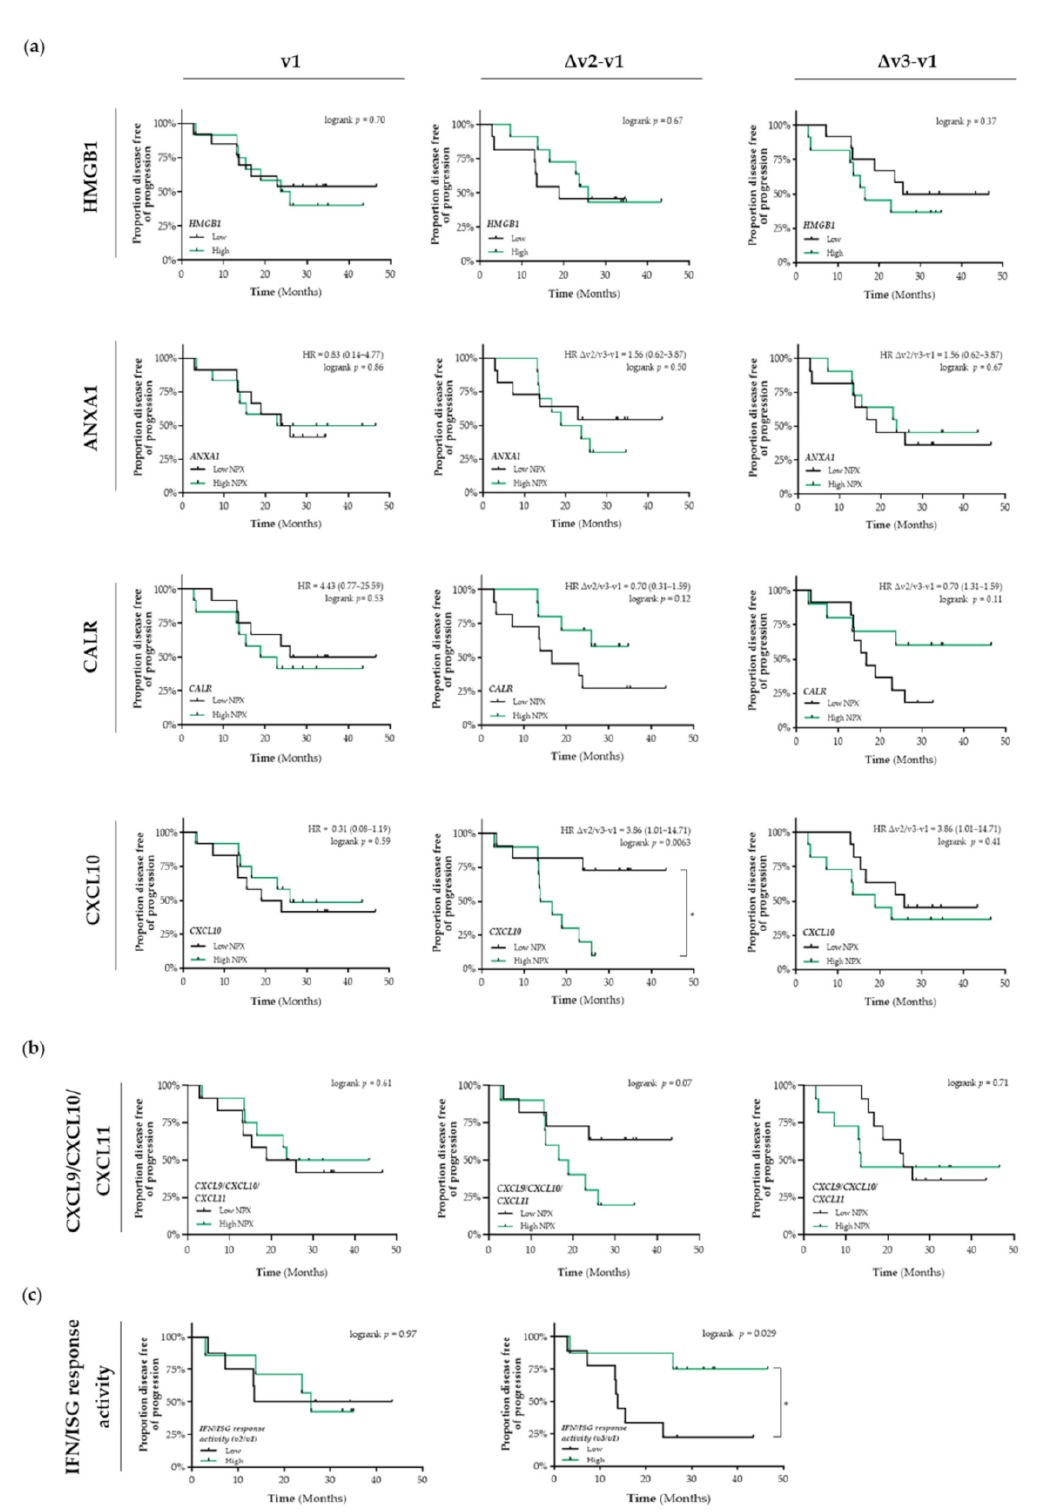
Figure 2. Detection of immunogenic cell death-related proteins in the circulation of patients with stage I NSCLC treated with SBRT. ( a ) Circulating levels of immunogenic cell death (ICD)-related proteins in patients with stage I NSCLC ( n = 25) at baseline (v1), after the 2nd fraction of SBRT (v2), after the final fraction of SBRT (v3) were assessed by ELISA (HMGB1) or by the Proximity Extension Assay from Olink (ANXA1, CALR, and CXCL10). Patients were stratified into low (black lines)